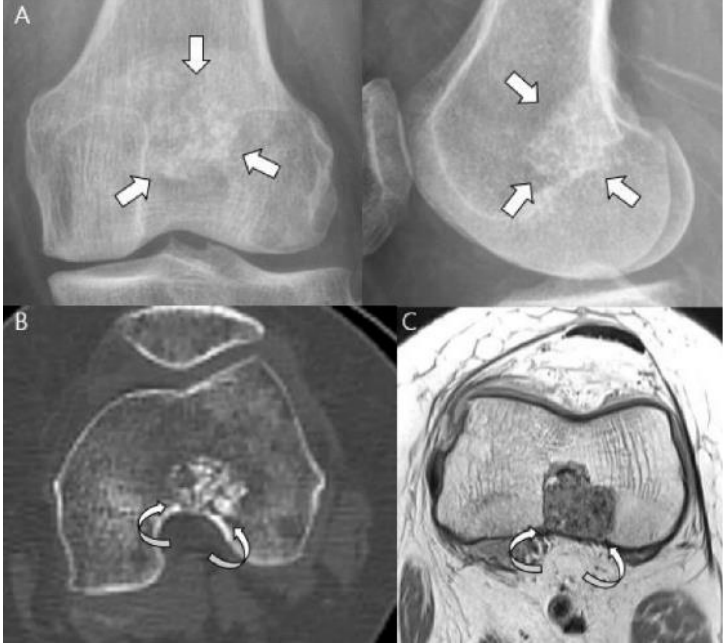
Figure 3. Atypical cartilaginous tumor of the distal femur in a 50-year-old woman. ( A ) Anteropos- terior and lateral radiographs reveal a mixed lytic and sclerotic lesion in the distal femur (arrows) with typical ring-and-arc calcifications. ( B ) Computed tomography and ( C ) axial T2-weighted image demonstrate a lobulated chondroid tumor with deep endosteal scalloping (curved arrows) de- spite the small tumor size (1.7 cm).